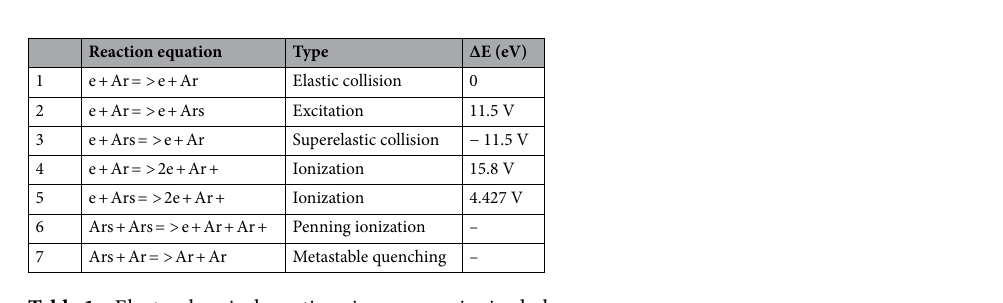
Table 1. Electrochemical reactions in an argon ionized plasma.